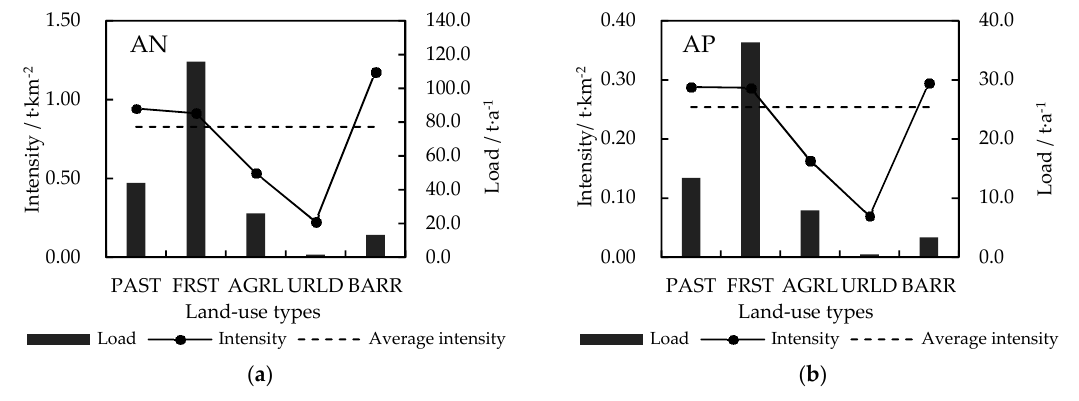
Figure 11. ( a ) AN and ( b ) AP loads and intensities of the different land-use types.